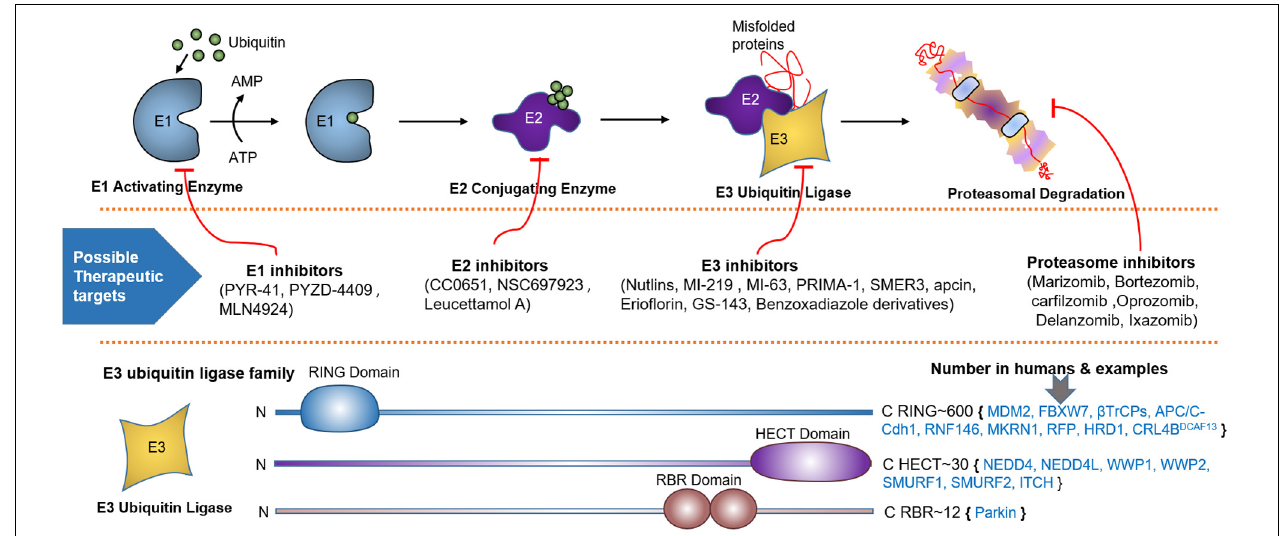
FIGURE 2 | Ubiquitin proteasome system (UPS), spots for therapeutic intervention and PTEN targeting E3 ligases. UPS is a highly sophisticated mechanism that tag proteins for proteasomal degradation through the coordinated actions of a series of enzymes, including E1 activating and E2 conjugating enzymes, and E3 Ubiquitin Ligase. Schematic description shows how E1-E3 enzymes mark substrate protein for degradation by linking it to the ubiquitin polypeptide. Below the UPS pathway, numerous spots for therapeutic intervention in the UPS cascade have been proposed that can either block or enhance ubiquitination. At the bottom, various families of E3 ubiquitin ligase based on unique functional domains, their approximate number in humans and PTEN targeting members are